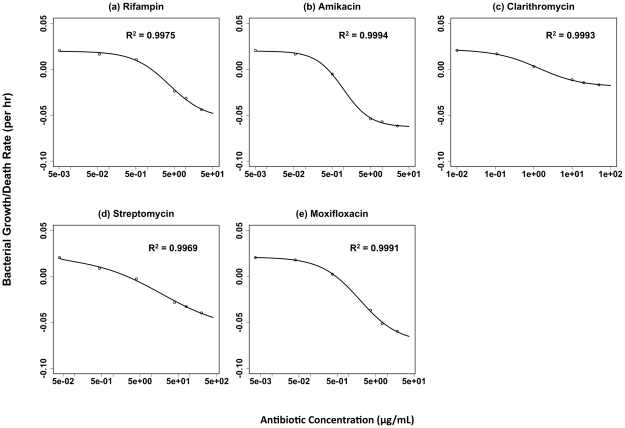
Fit of the Hill function to time-kill data for single antibiotics.Adjusted R2 values determined from an F test are shown. (a) Rifampin, (b) Amikacin, (c) Clarithromycin, (d) Streptomycin, (e) Moxifloxacin.